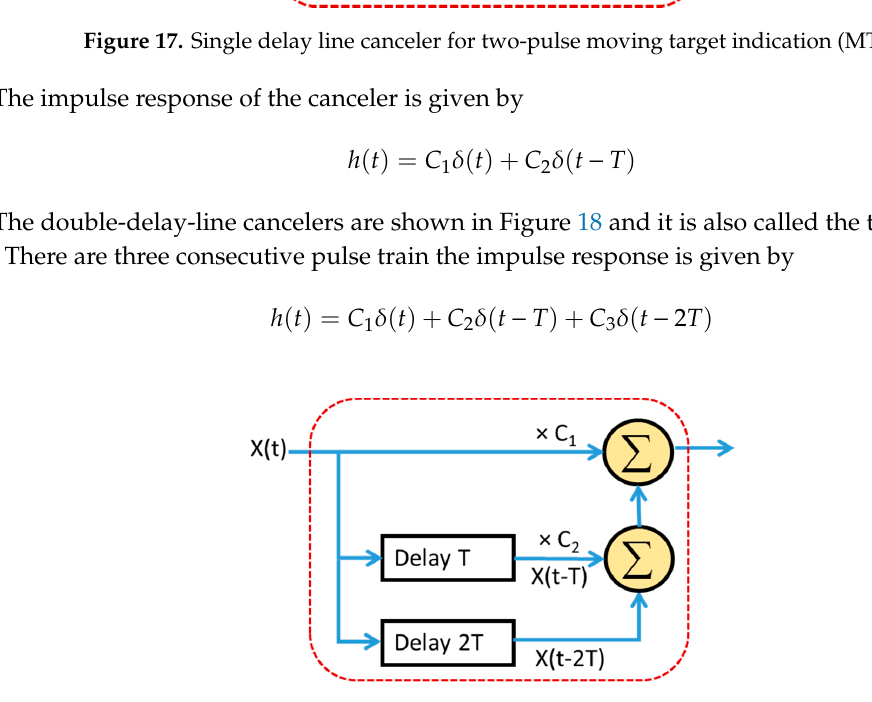
Figure 18. Double delay line canceler for three-pulse moving target indication (MTI).